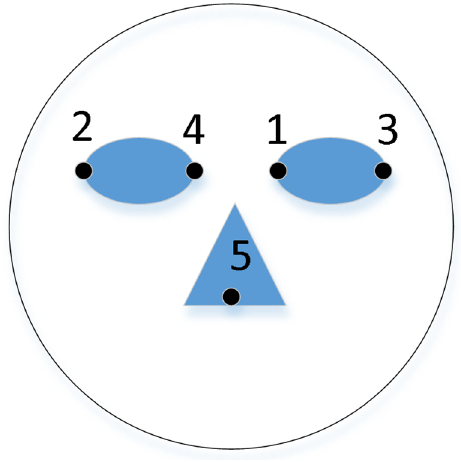
Figure 5. The five-point facial feature points used in face detection.